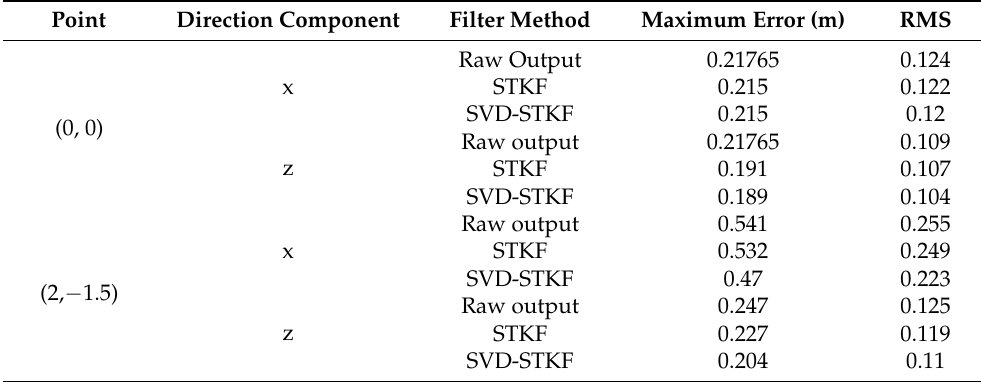
Table 2. Source rotation test error statistics.